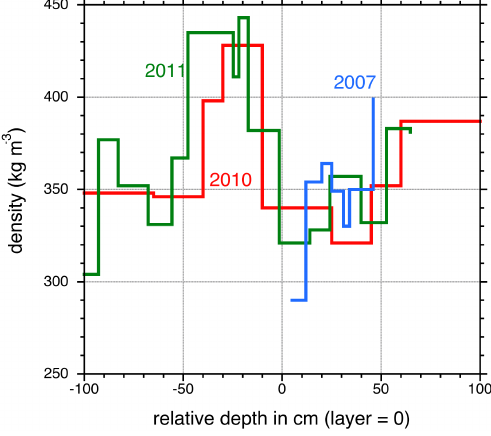
Figure 3. Density measurements, with depth resolution of 10cm, performed at our site in the years 2007, 2010 and 2011. The depths have been shifted such that our enriched layer (with an estimated thickness of typically 2cm) is at relative depth zero. Our enriched layer, deposited at the end of the summer of 2007, is on top of a summer layer with lower density than the preceding and following winter